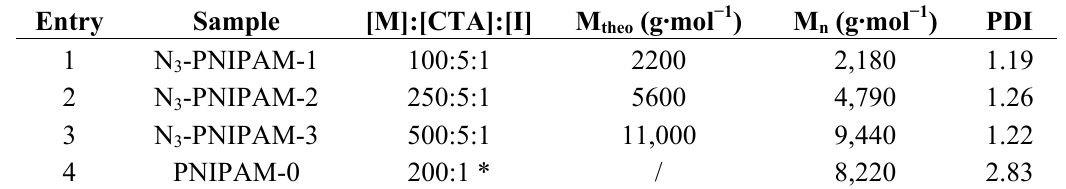
Table 1. The feed ratio of polymerization and the GPC analysis results of serial -PNIPAM and N 3